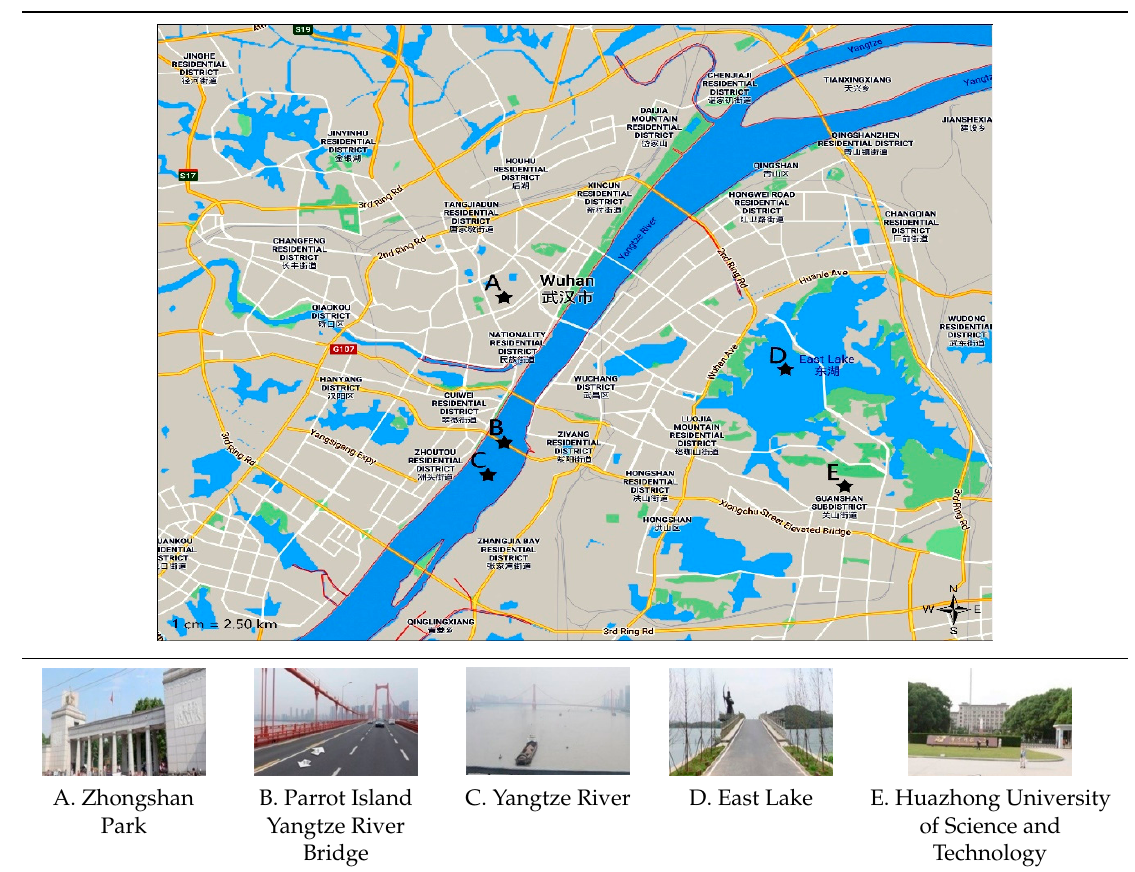
Table 5. Comparison of the functions identified in this study and streetscape map.